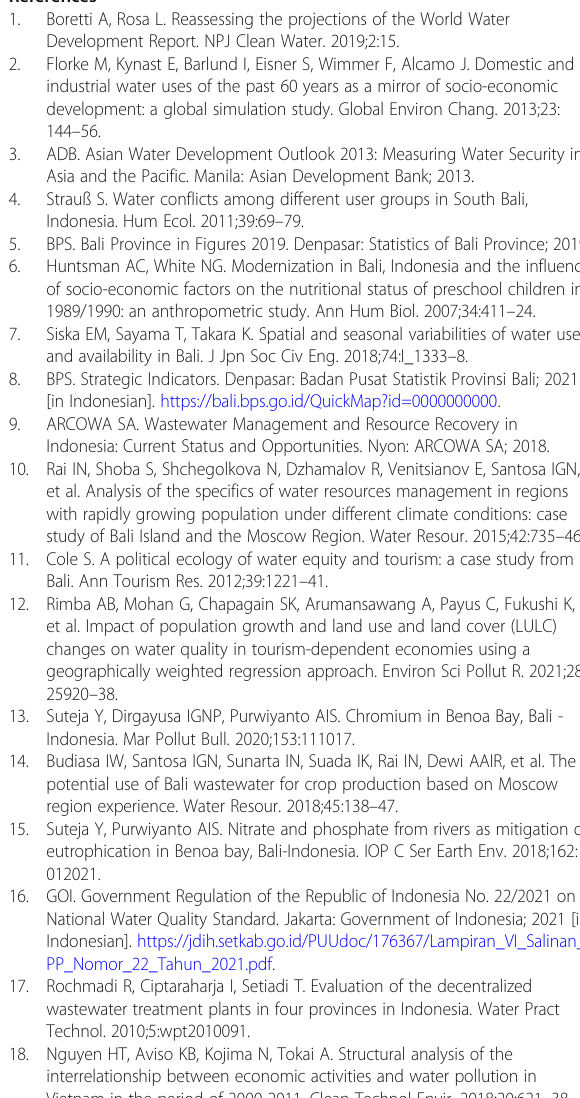
Additional file 1: Table S1. Re-classification of sector for Bali